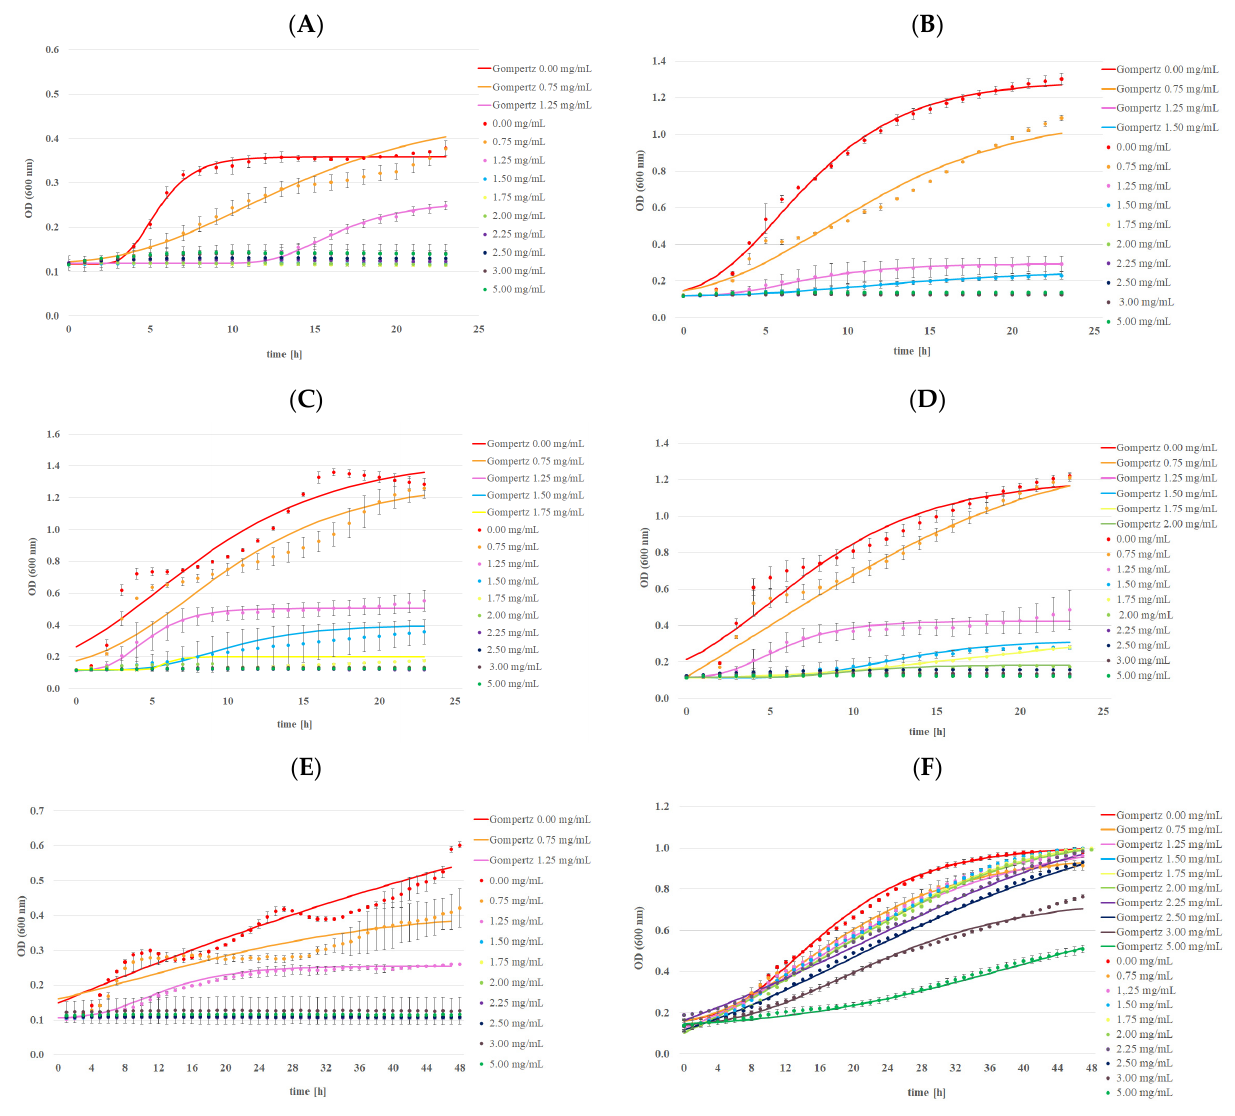
Figure 5. The effect of mandelic acid at different concentrations on the growth profiles of tested bacterial strains: ( A ) L. monocytogenes ATCC 13932, ( B ) S. aureus ATCC 25923, ( C ) E. coli ATCC 25922, ( D ) S. typhimurium ATCC 14028, ( E ) B. subtilis ATCC 6633, and ( F ) L. backii KKP 3566, using Bioscreen C Pro.